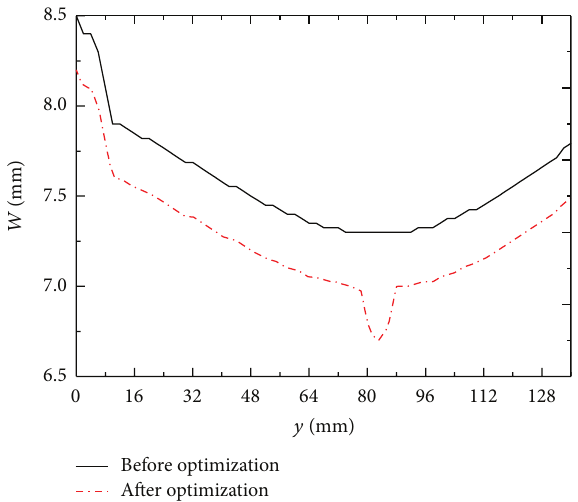
Figure 9: Variation of the aperture depth before and after optimiza- tion.